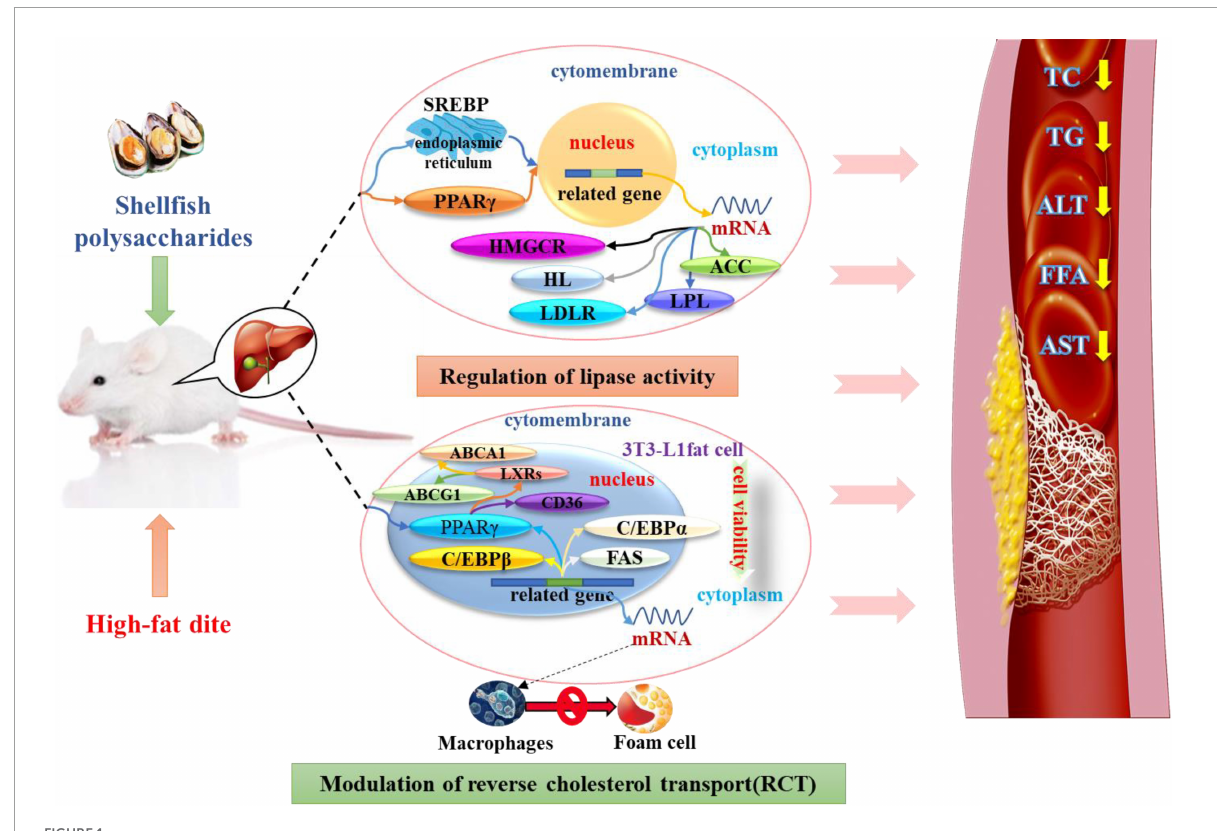
FIGURE1 Shellfish polysaccharides regulate lipase and RCT lipid-lowering